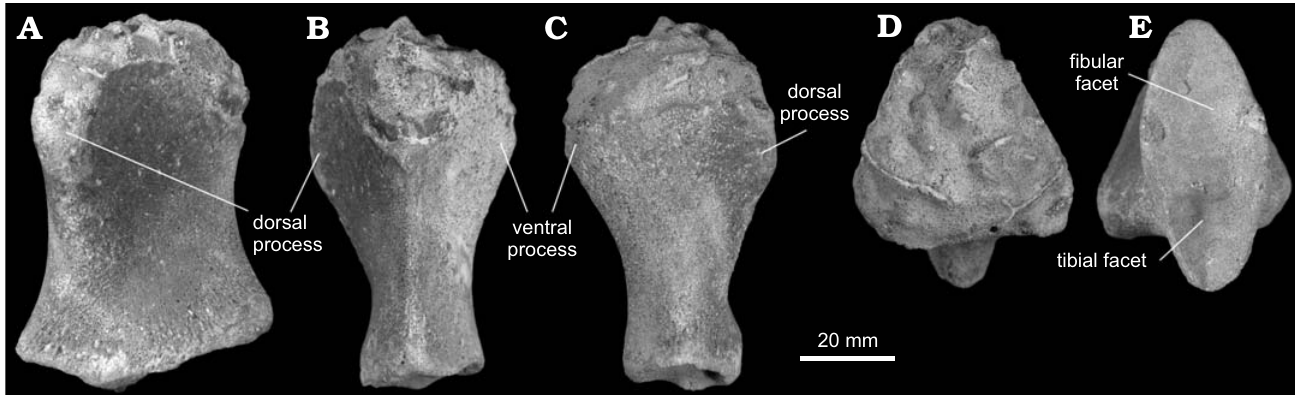
Fig. 9. Left femur of ophthalmosaurid ichthyosaur Cryopterygius kielanae sp. nov. (GMUL 3579-81, holotype) from the Late Jurassic of Owadów- Brzezinki Quarry; in dorsal ( A) , posterior ( B ), anterior ( C ), proximal ( D ), and distal ( E ) views.